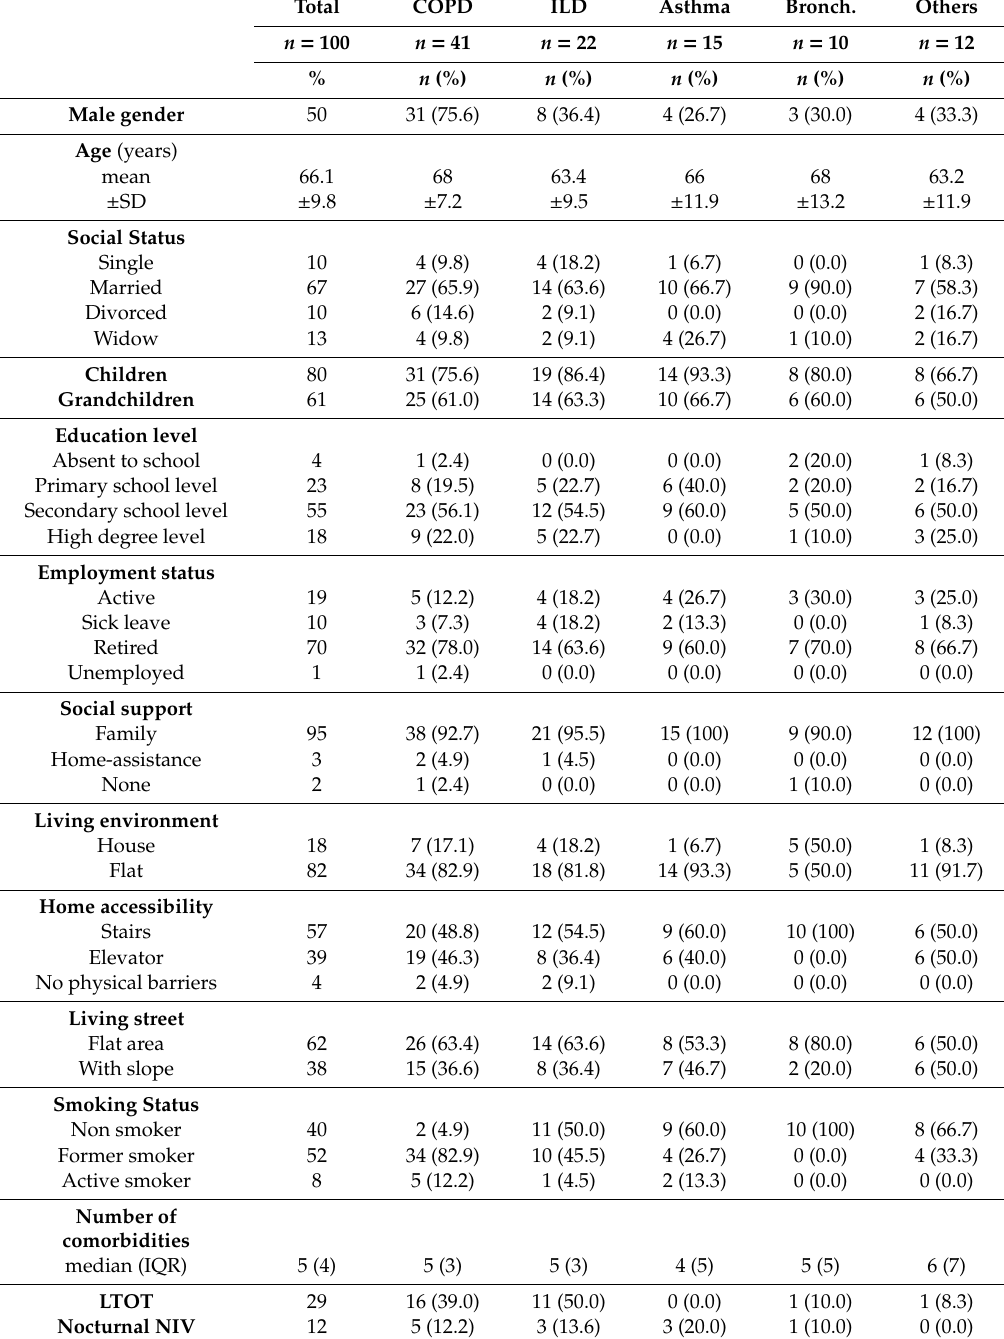
Table 1. Patients’ characteristics per chronic respiratory